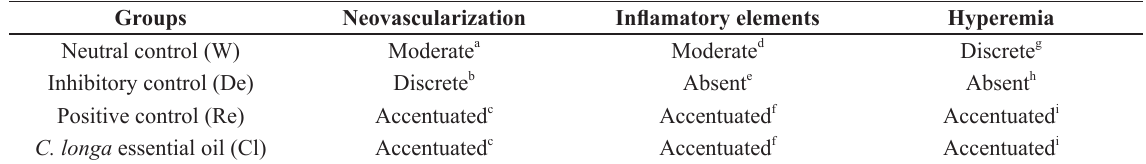
Different histological parameters observed in CAMs submitted to different